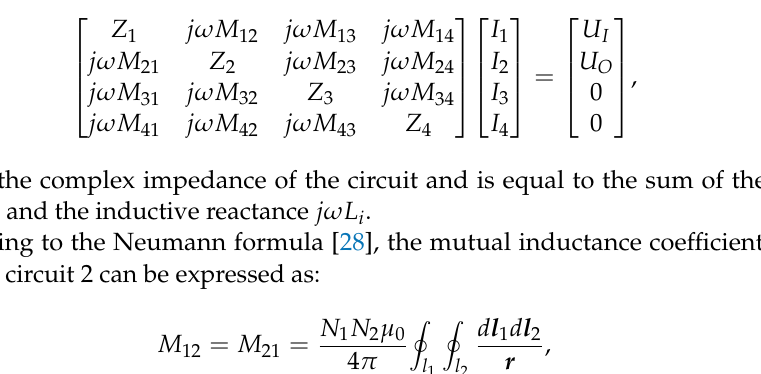
Figure 2. Mutual inductance model for detection of the balanced-field electromagnetic technique.